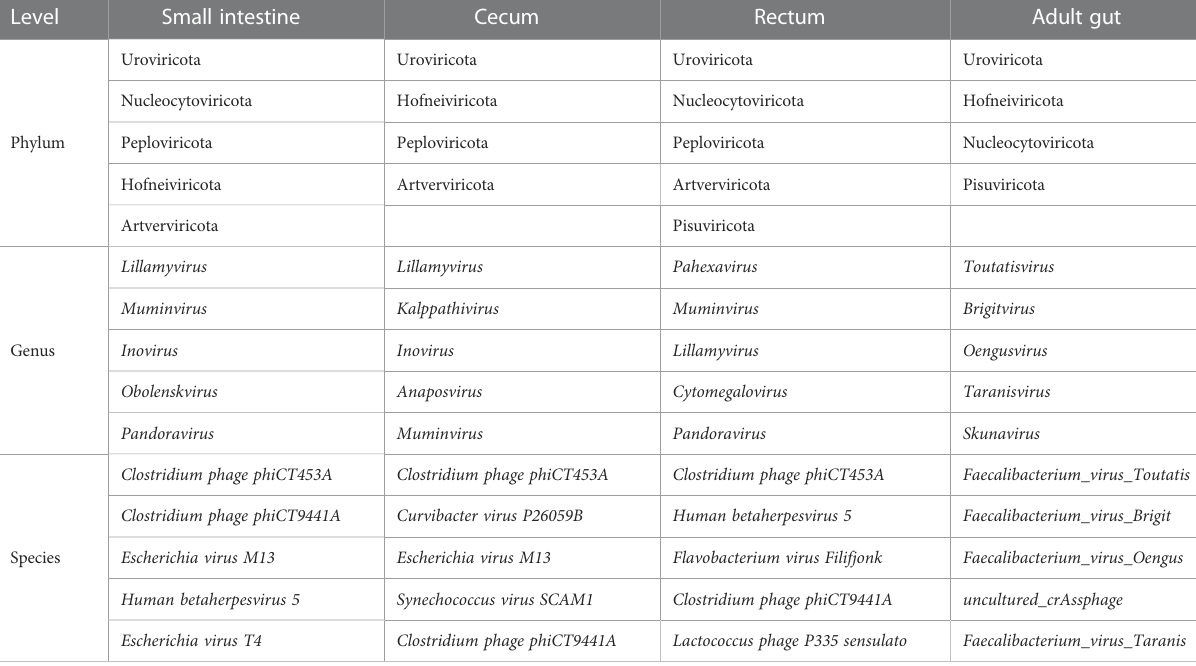
TABLE 2 Top 5 viruses at phylum, genus and species level (virome).